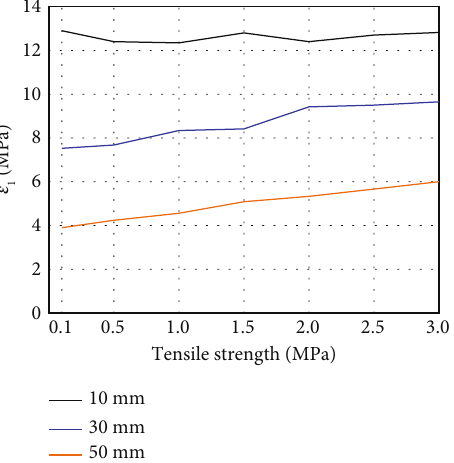
Figure 15: Peak strain of limestone grouting reinforcement bodies under di ff erent crack lengths and di ff erent bonding tensile strength values of grouting stone